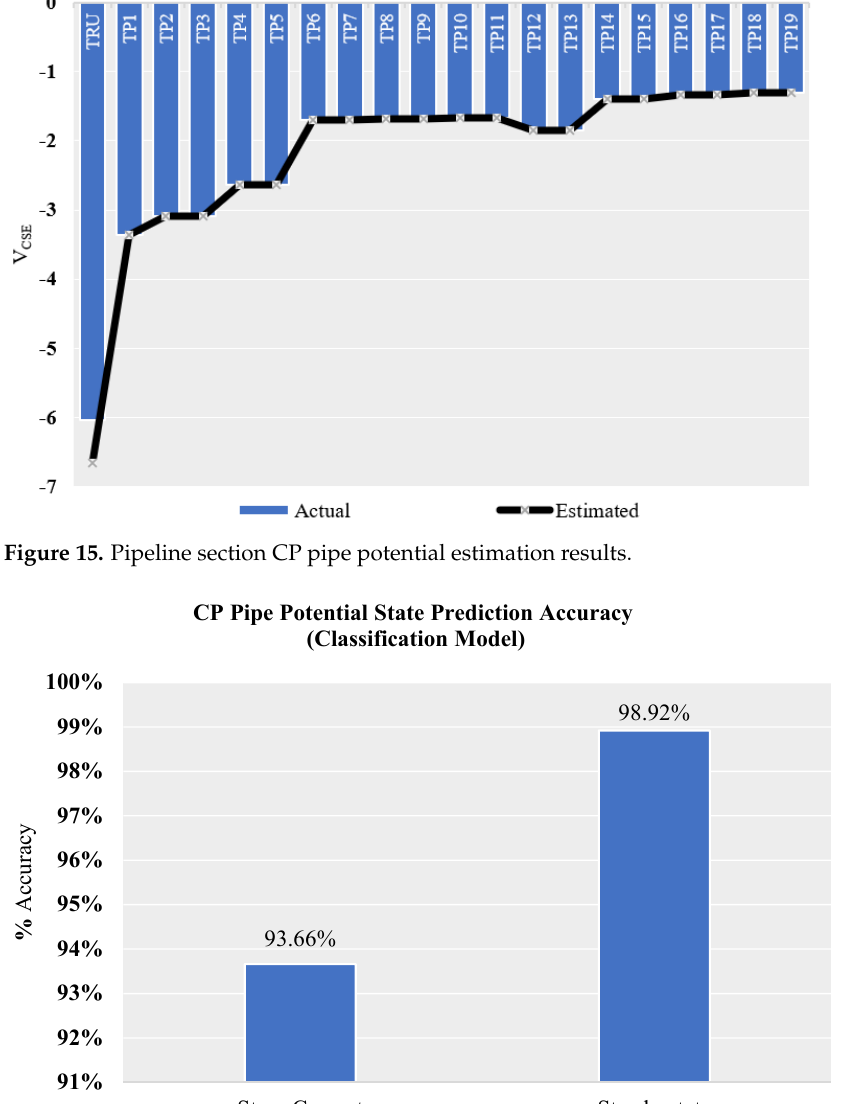
Figure 15. Pipeline section CP pipe potential estimation results.